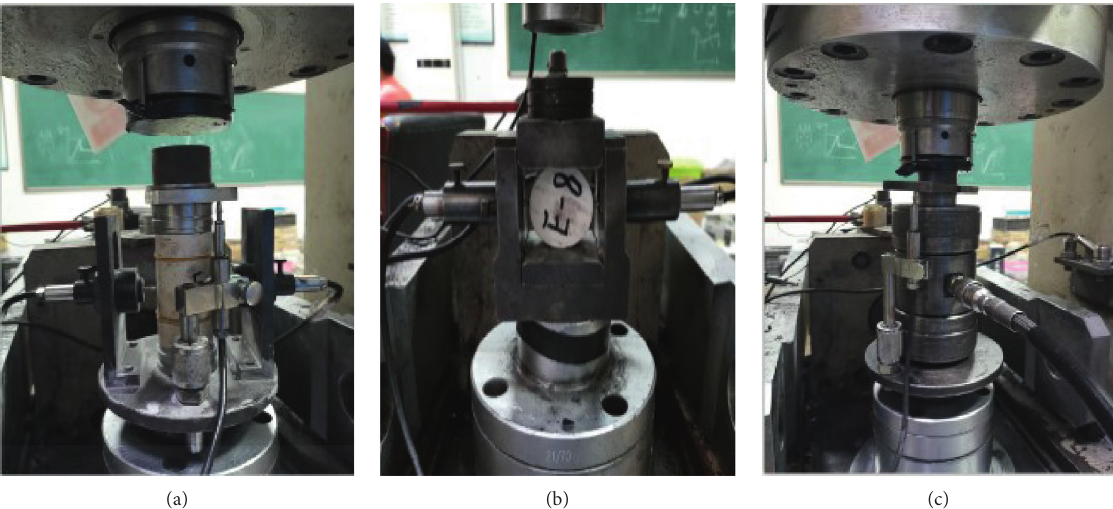
Figure 4: Test of physical and mechanical properties of the high-strength gypsum powder remolded sample. (a) Uniaxial compression. (b) Brazil spilt. (c) Triaxial